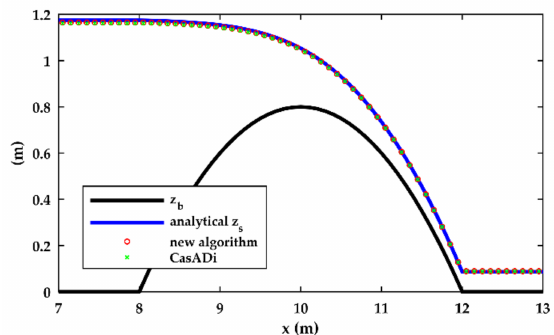
Figure 4. Comparison between the analytical solution and the numerical results produced by the new algorithm and CasADi for validation test B.